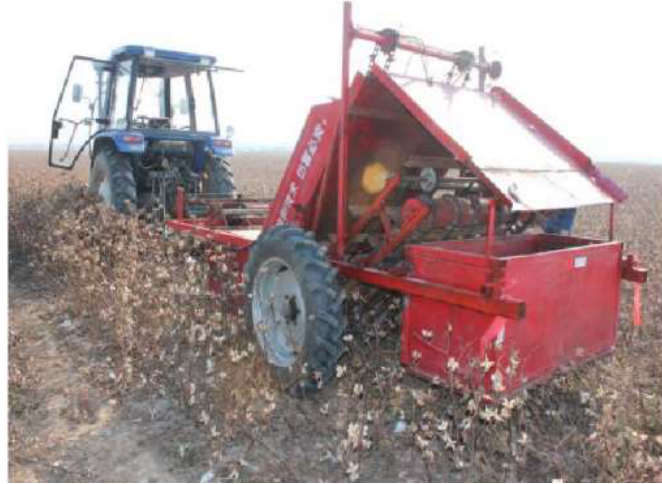
Figure 5. Machine of clamp conveying type residual film